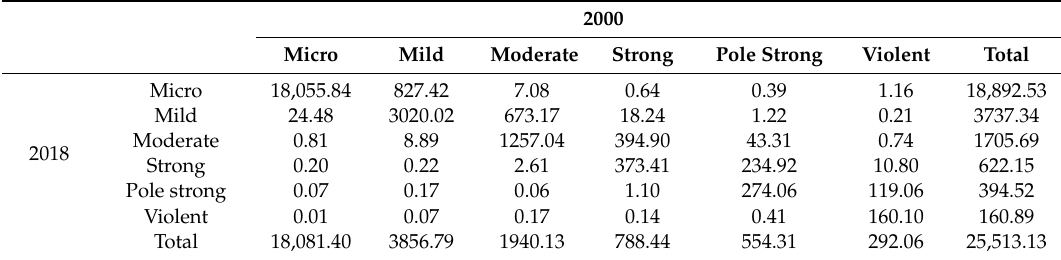
Table 9. The transfer matrix of soil erosion intensity grades in the Taohe River Basin from 2000 to 2018 (km 2